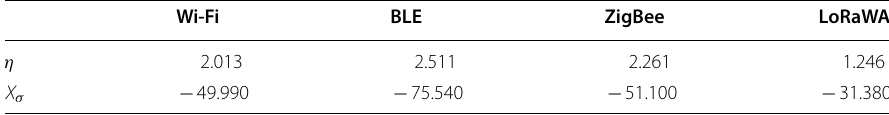
Table 1 Parameters used in environment 1